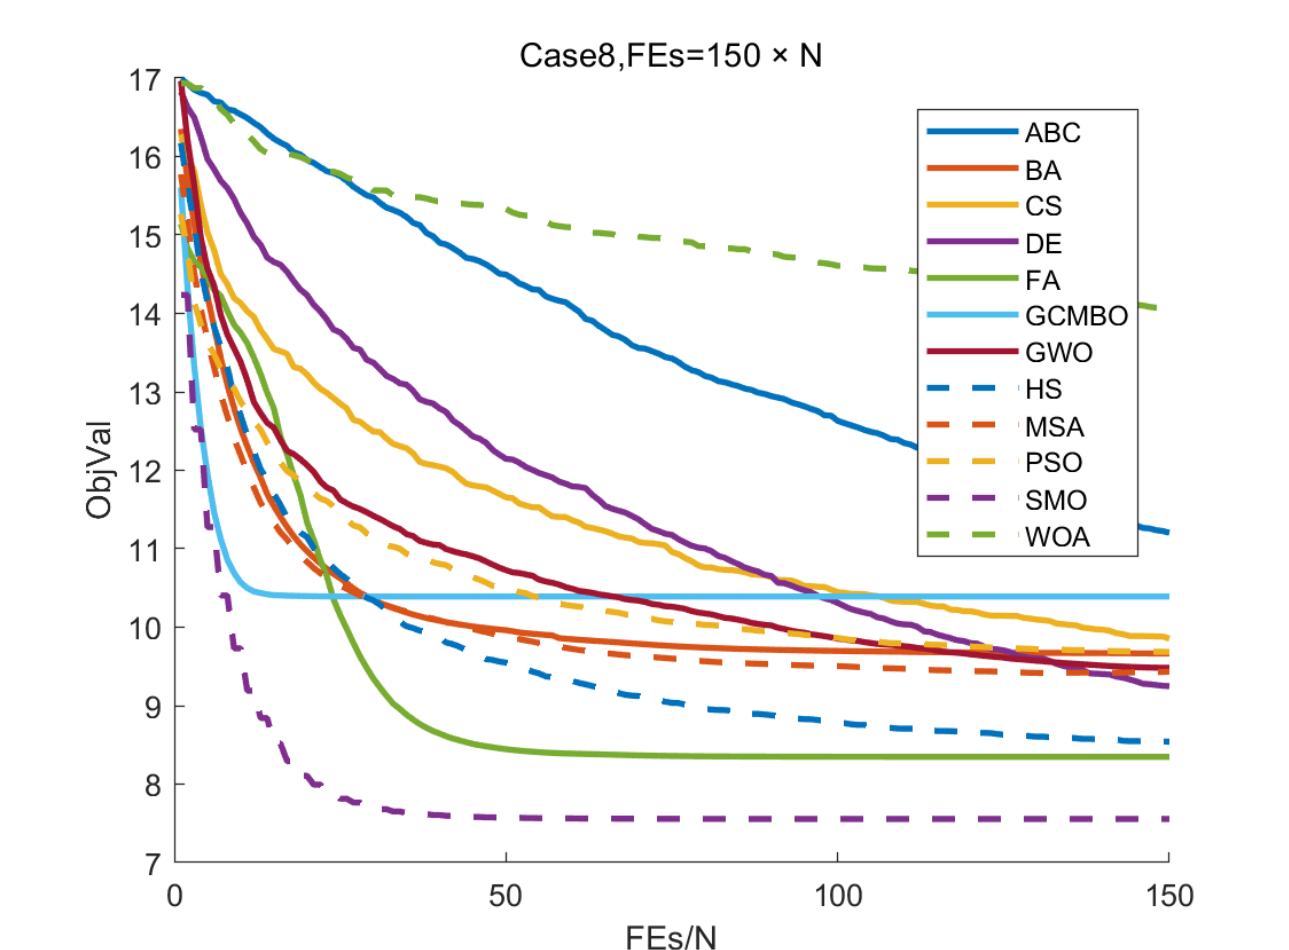
Figure 12. The convergence rate of different SI algorithm for Case 8 with large-scale. The horizontal axis denotes the number of fitness evaluations divided by the size of the population N , which is the iteration times. The vertical axle is the average objective value over 25